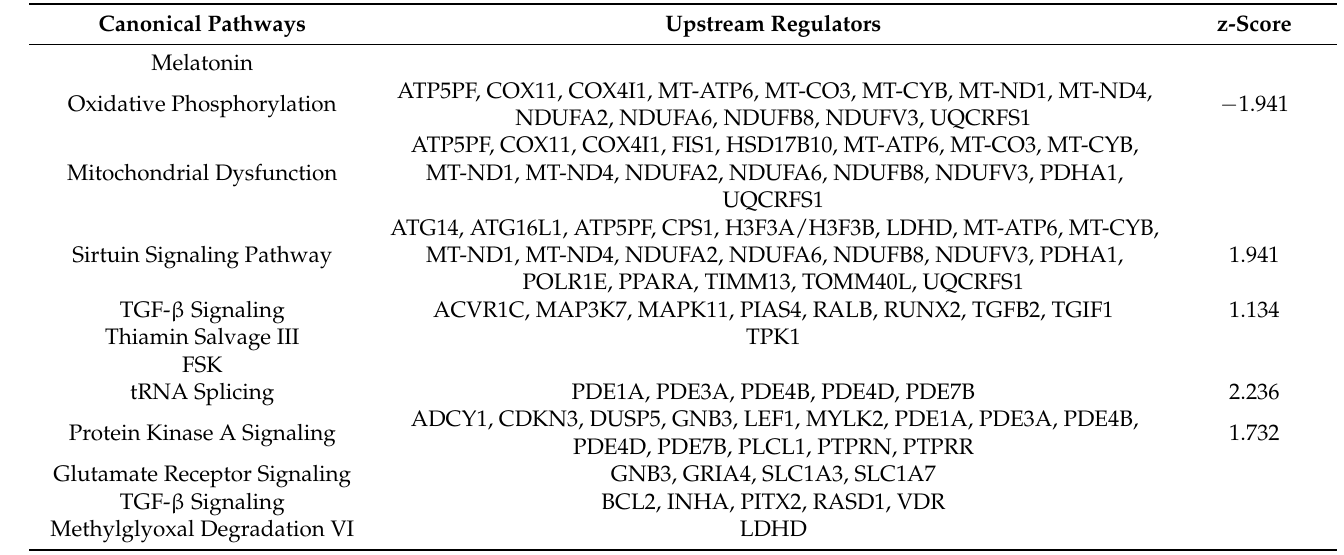
Table 3. Canonical pathways affected by the treatments and related upstream regulators identified by